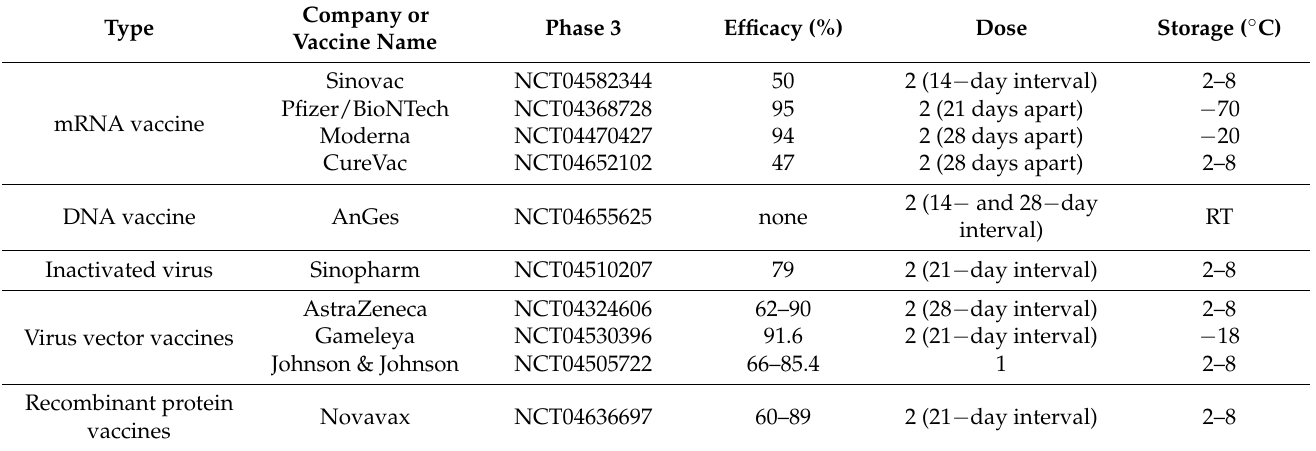
Figure 12. Global vaccine efficacy maps in different countries. The vaccines that have been used in different countries are color-coded by the vaccine types (RNA vaccine, DNA vaccine, inactivated vaccine, virus vector vaccine, and recombinant protein vaccine). In each highlighted country, the name and efficacy of the vaccines are provided in this map. Table 3. Summary of vaccine information (efficacy, name or manufacturer, development phase, efficacy, dose, and storage condition) for different types of vaccines worldwide. Note that RT means room